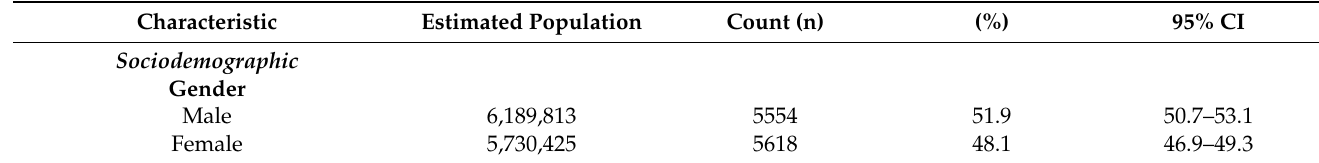
Table 1. Characteristics of the adult respondents aged 18 years and above (n =